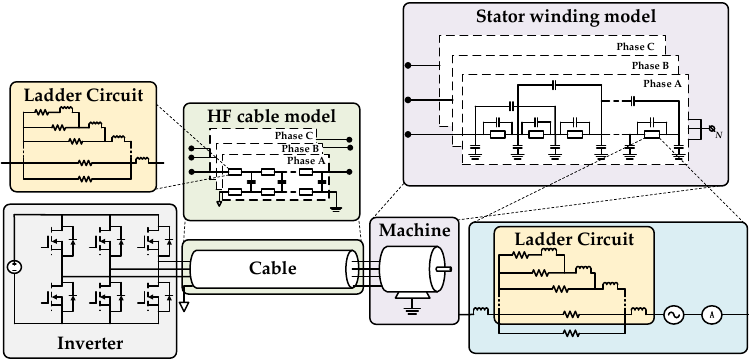
Figure 9. HF model for voltage transient prediction